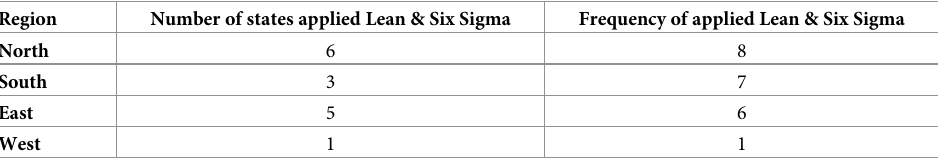
Table 3. Detail of Lean & Six Sigma in different regions of